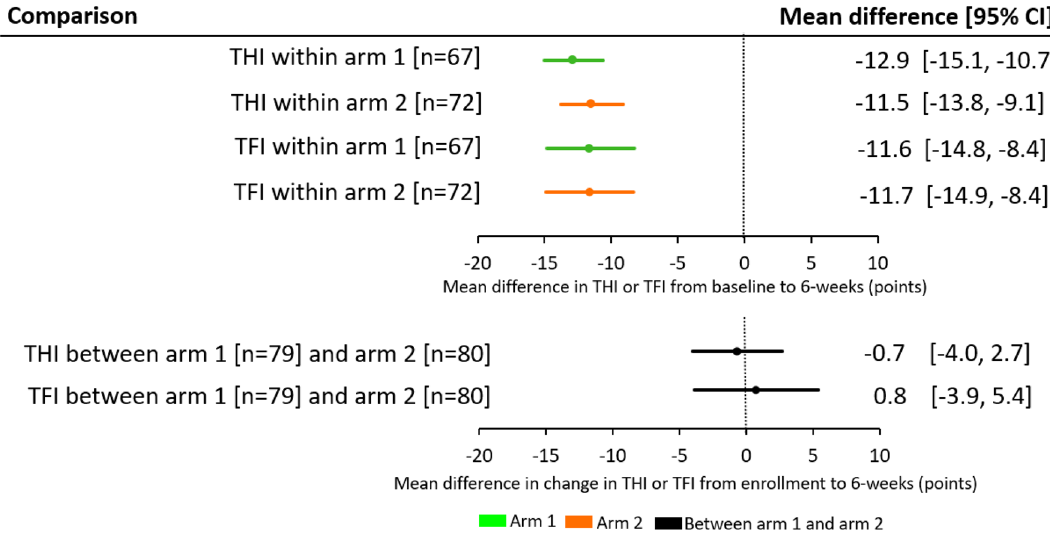
Figure 3. Within-arm and between-arm analyses for primary endpoints at 6-weeks. The mean differences in THI and TFI scores across participants for arm 1 and arm 2 from baseline to 6-week assessment for the within-arm cases, or the mean differences between arm 1 and arm 2 for the change in scores from enrollment to 6-week assessment for the between-arm cases are plotted with the ± 95% CI. Within-arm analyses were based on per-protocol analysis that included treatment-compliant participants (≥ 18 h treatment at 6-weeks) with baseline and 6-week scores. The baseline score corresponds to the average of the scores at screening and enrollment visits. Within-arm analyses for arm 1 and arm 2 showed a highly statistically significant reduction in THI and TFI scores (i.e., improvement in tinnitus symptom severity) based on paired two-tailed t-tests ( P < 0.0001; 95% CI does not overlap the vertical line at zero). Between-arm analyses were conducted using an intention-to- treat analysis with changes in THI or TFI scores from the enrollment to 6-weeks assessment and tested with multiple regression using enrollment score as a covariate. Missing data were imputed using the Markov chain Monte Carlo multiple imputation method (further details are provided in the Methods), which leads to n values that match the enrolled numbers for each arm. There was no significant difference between arm 1 and arm 2 ( P > 0.05; 95% CI crosses vertical line at zero). Note that primary endpoint analyses included within-arm changes for THI and TFI for arm 1 and between-arm differences for arm 1 and arm 2 only for THI, but that the other within-arm and between-arm comparisons are presented in this figure for completeness. Parameter settings (see Supplementary Table S1 for details): arm 1—PS1 (synchronized bimodal stimulation, includes pure tones and background noise stimuli); arm 2—PS6 (includes only pure tones with no background noise stimuli and with varied interstimulus delays in the range of 700–800